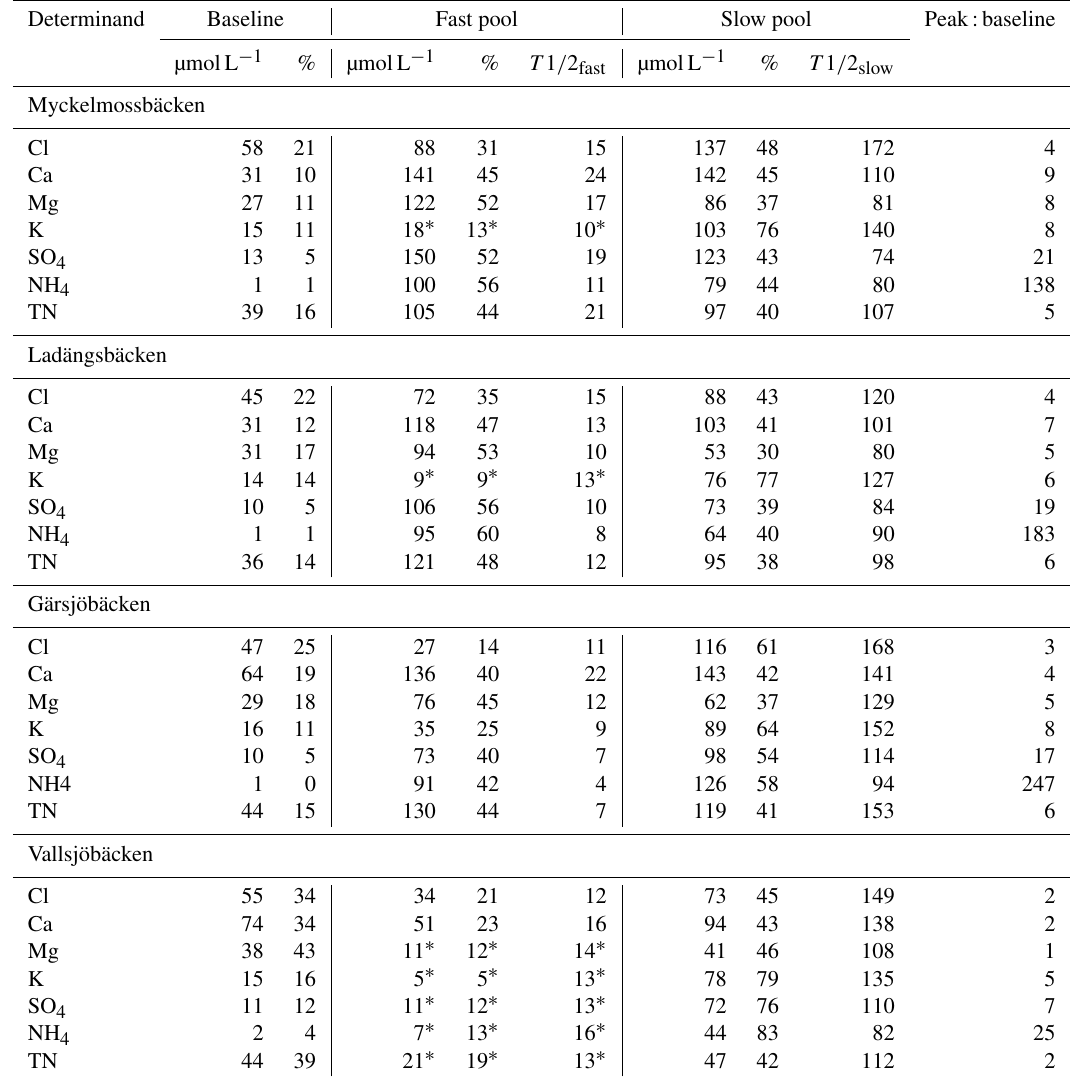
Table 3. Decay curve modelling. Fitted initial and baseline pool concentrations, percentages, pool half-lives, and peak:baseline ratios for solutes exhibiting a single post-fire concentration peak in the four studied streams. Asterisks indicate that the 95% credible interval of the fast-pool parameter included